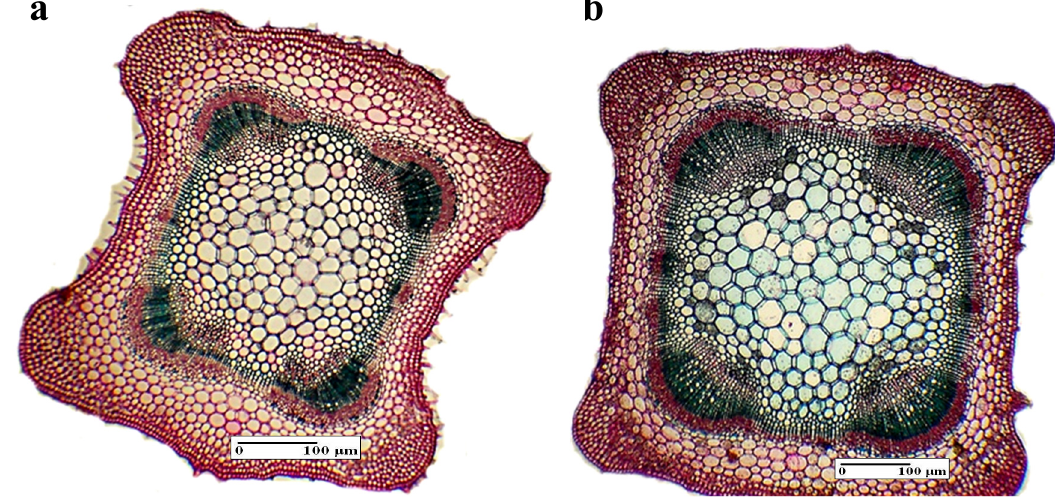
Figure 5. The internal structure of the stem: ( a ) general aspect (control), ( b ) general aspect (BBPE 1).